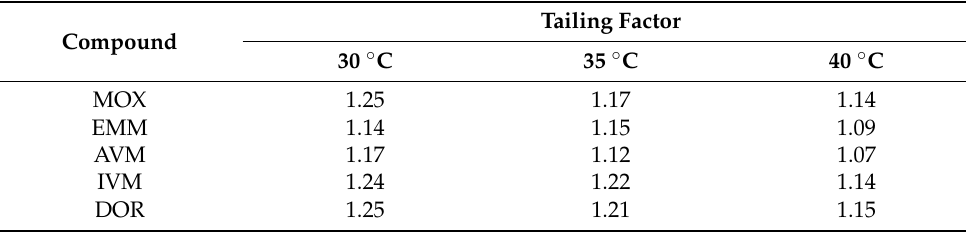
Table A1. The tailing factor of 100 µ g/kg AVMs standard at 30 ◦ C, 35 ◦ C and 40 ◦